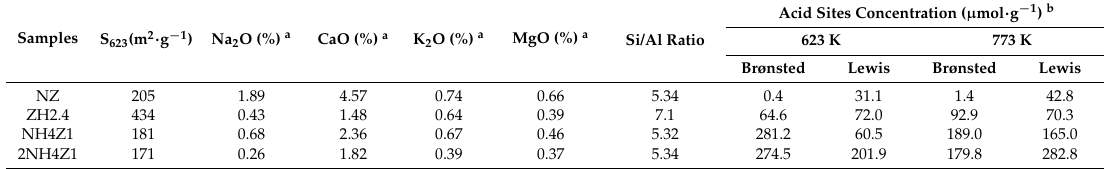
Table 1. Characterisation of zeolite